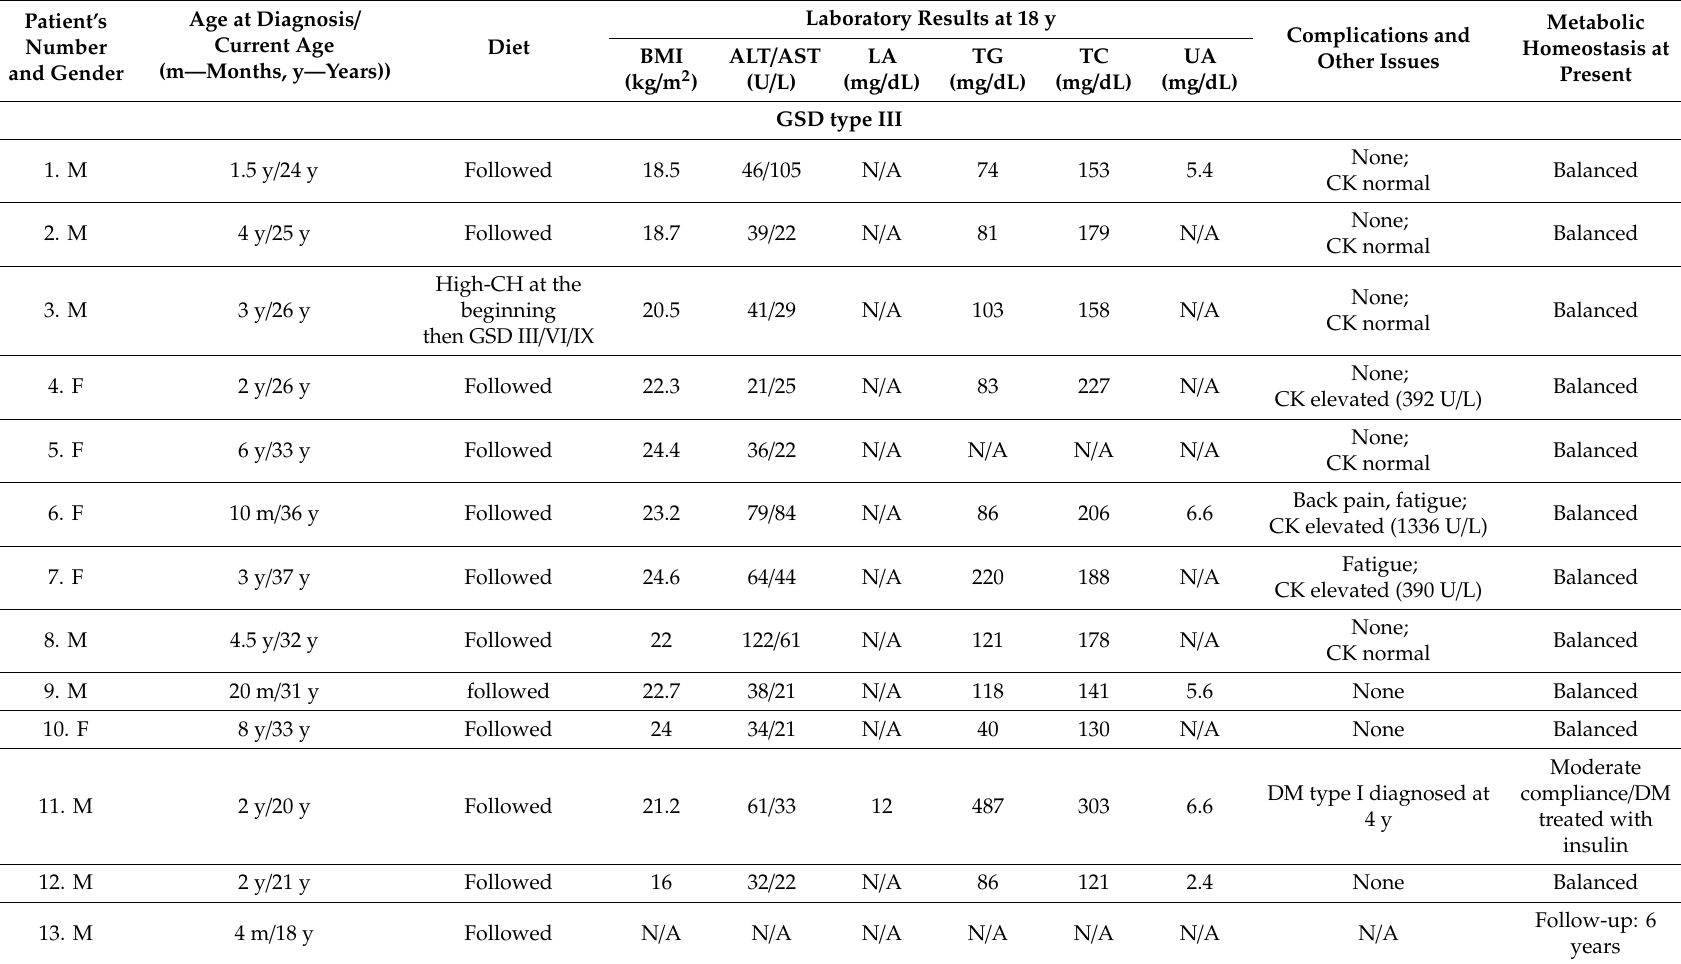
Table 2. Detailed characteristics of adult patients with GSD types III / VI / IX included in the study ( n =